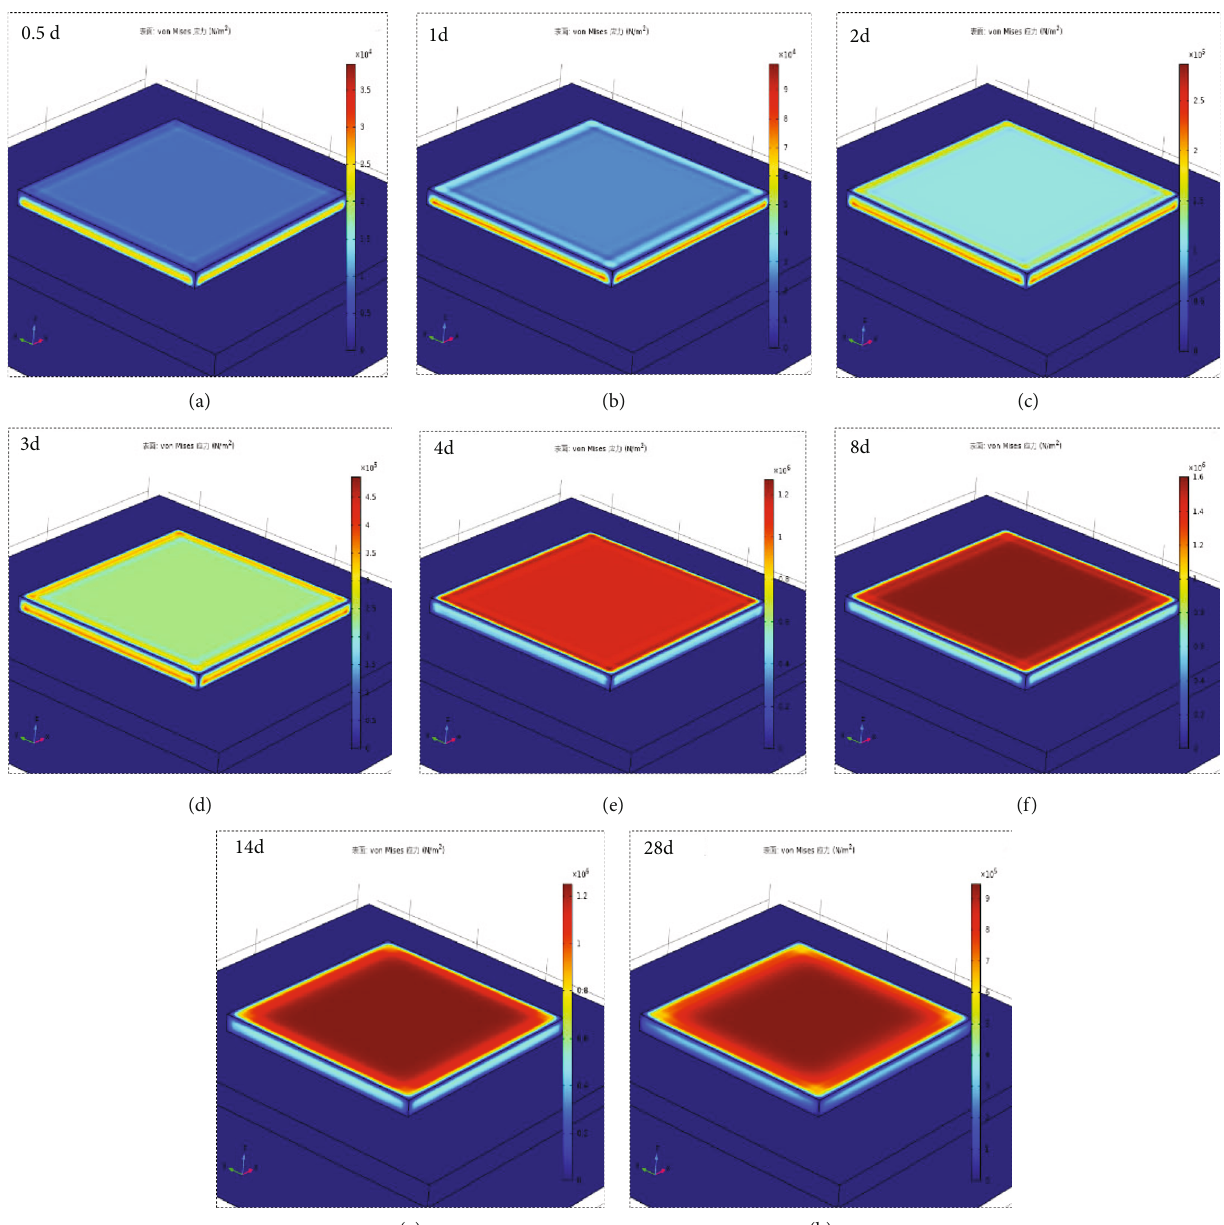
Figure 5: Temperature stresses in mass concrete at di ff erent